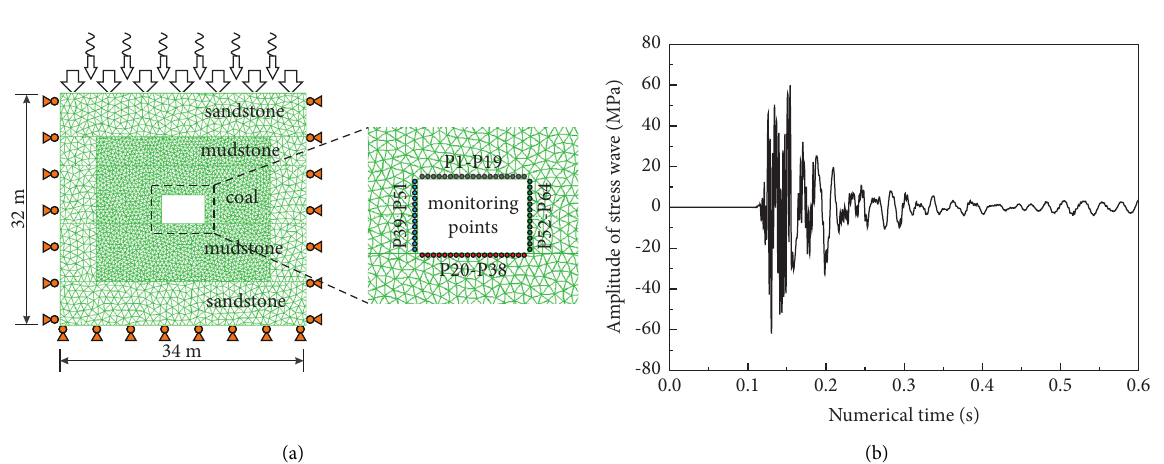
Figure 5: Numerical simulation scheme diagram of roadway. (a) Numerical model of the roadway. (b) Mine earthquake wave